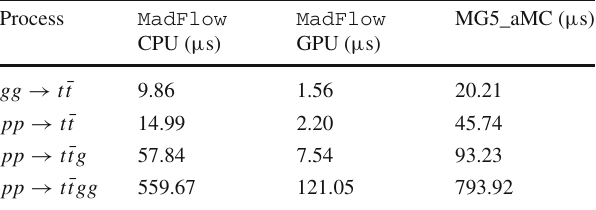
Table 1 Comparison of event computation time for MadFlow